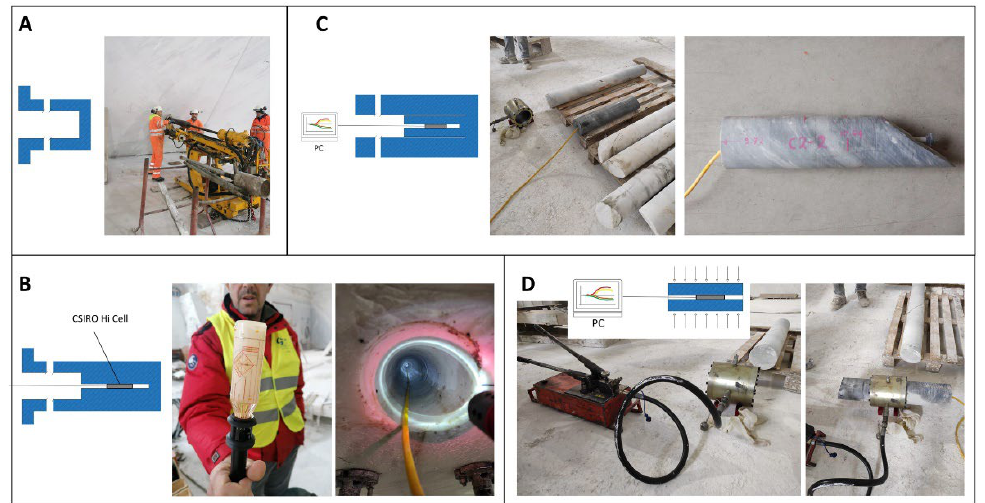
Figure 6. Summary of the working phases using the CSIRO HI cell and overcoring method. ( A ) Drilling of the first borehole up to the planned depth; ( B ) mounting of CSIRO HI cell inside the pilot borehole; ( C ) cell overcoring; ( D ) execution of biaxial compression test through the Hoek–Franklin cell and stress–strain data estimation.